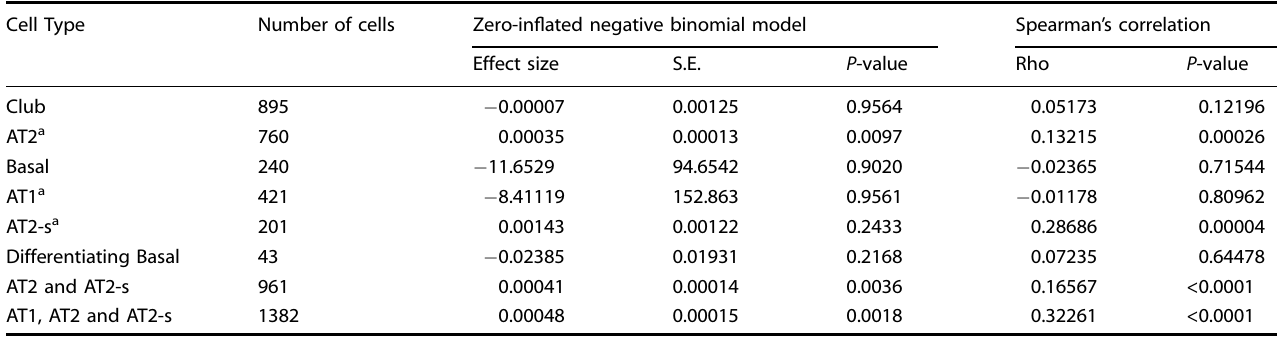
Table 5. Co-expression between SLC26A9 and CFTR using the Human Lung Cell Atlas data 40 .